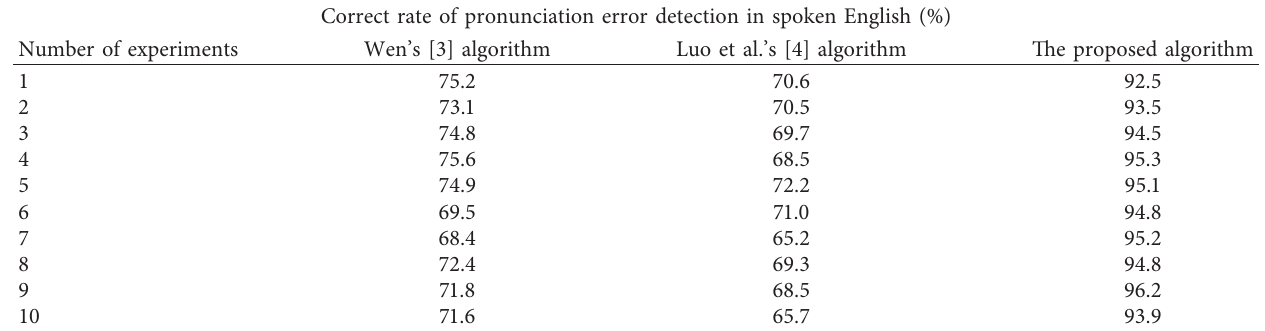
Table 2: Data table of correct rate of pronunciation error detection in spoken English.